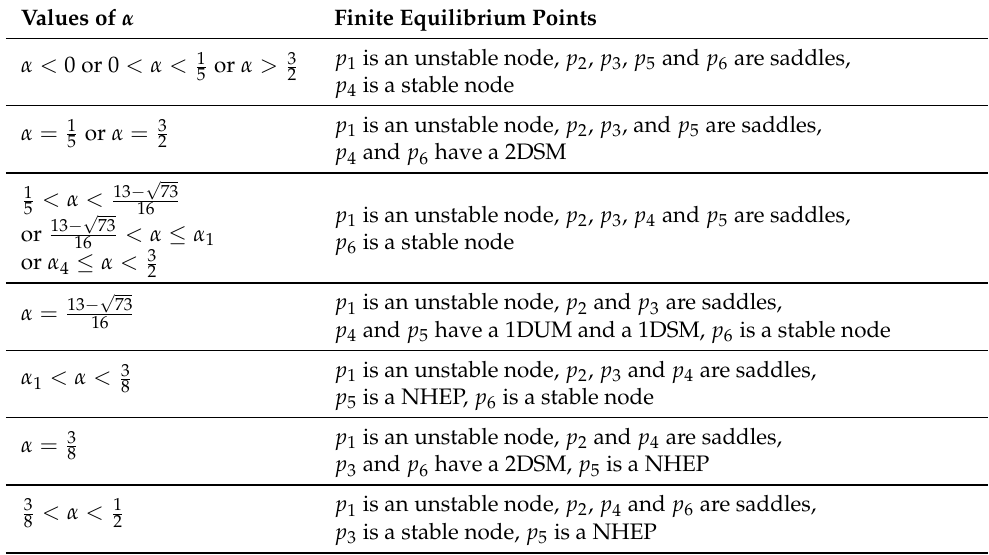
Table 2. Finite equilibrium points and their types for different values of α of system